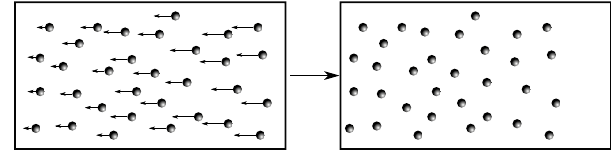
FIG. 2. Time evolution of gas particles in a box with perfectly reflecting walls. Left: Initially, all gas particles have a veloc- ity pointing to the left such that in the next time step none of them is reflected to the right. This is an extremely unlikely state and an experimental preparation of it requires precise control about every single gas particle. Right: Given the initial state on the left, the state of the gas after the time step is characterized by a lower entropy, in seeming violation to the second law of